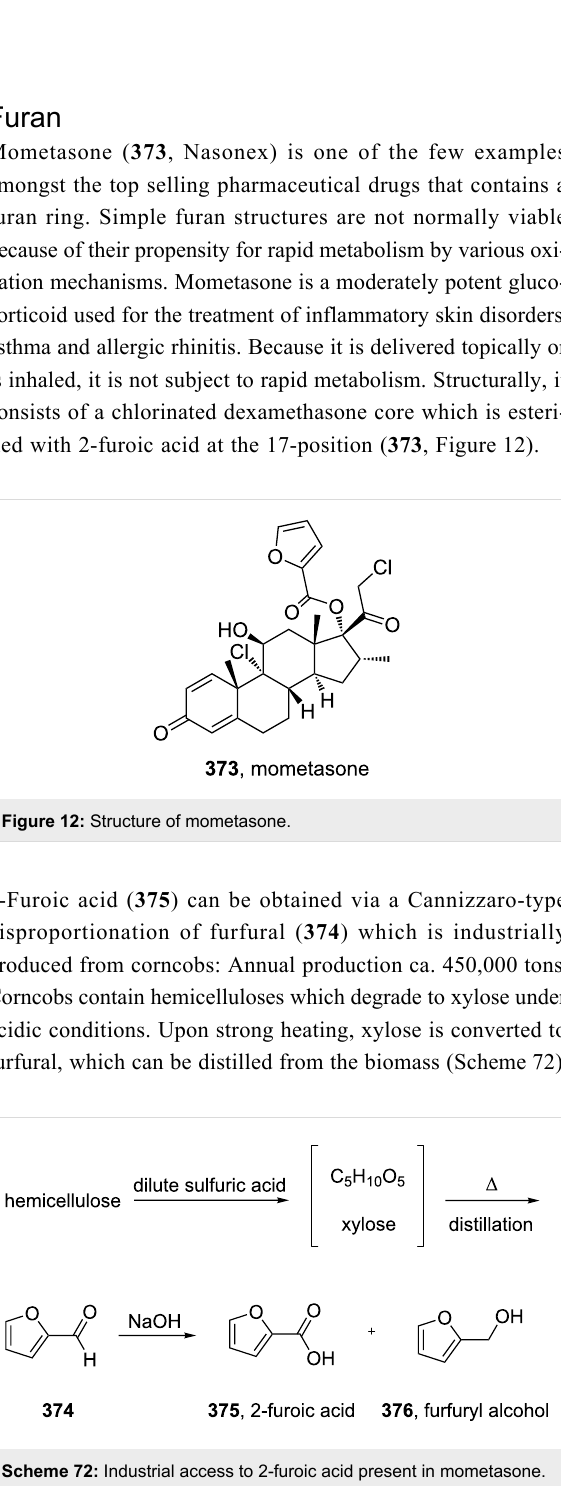
The furfuryl alcohol ( 376 ) obtained in the abovementioned disproportionation (Scheme 72) is also a key starting material for the peptic ulcer therapeutic ranitidine ( 377 , Zantac). In the synthesis of this H 2 -receptor antagonist, furfuryl alcohol is subjected to a Mannich reaction with paraformaldehyde and dimethylamine hydrochloride. The resultant (5-((dimethyl- amino)methyl)furan-2-yl)methanol ( 378 ) is then treated